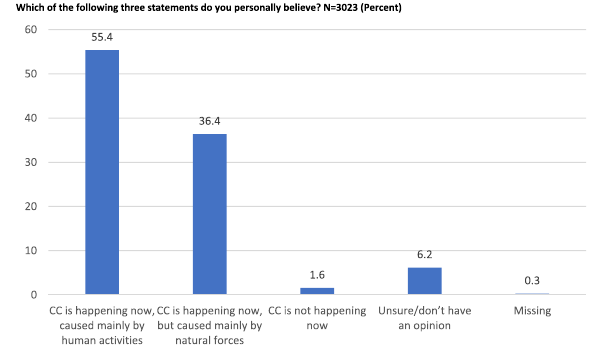
Fig. 1 Univariate prevalence. Which of the following three statements do you personally believe? N = 3023